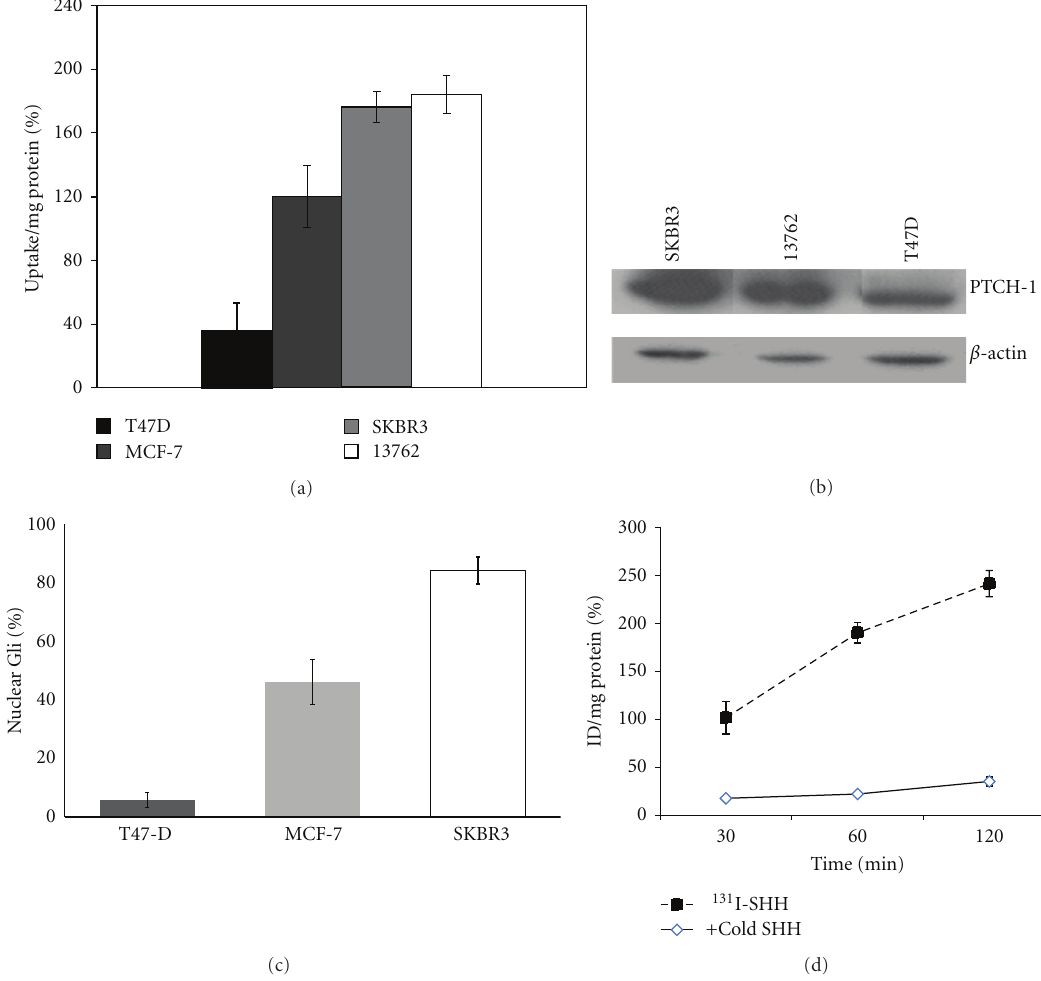
Figure 2: (a) Cellular uptake of 131 I-SHH in breast cancer cell lines at one hour. Data is represented as the % injected dose (cpm (cells)/cpm (media))/mg protein. (b) Western blot showing expression of PTCH-1 in breast cancer cell lines. Cellular uptake of 131 I-SHH is correlated with expression of the PTCH-1 receptor. (c) Nuclear Gli-1 expression in breast cancer cell lines. Data is expressed as number of cells with intense nuclear Gli-1 staining. (d) Time course showing increased accumulation of 131 I-SHH in SKBR3 cancer cells with time. Uptake was blocked by 100-fold excess cold